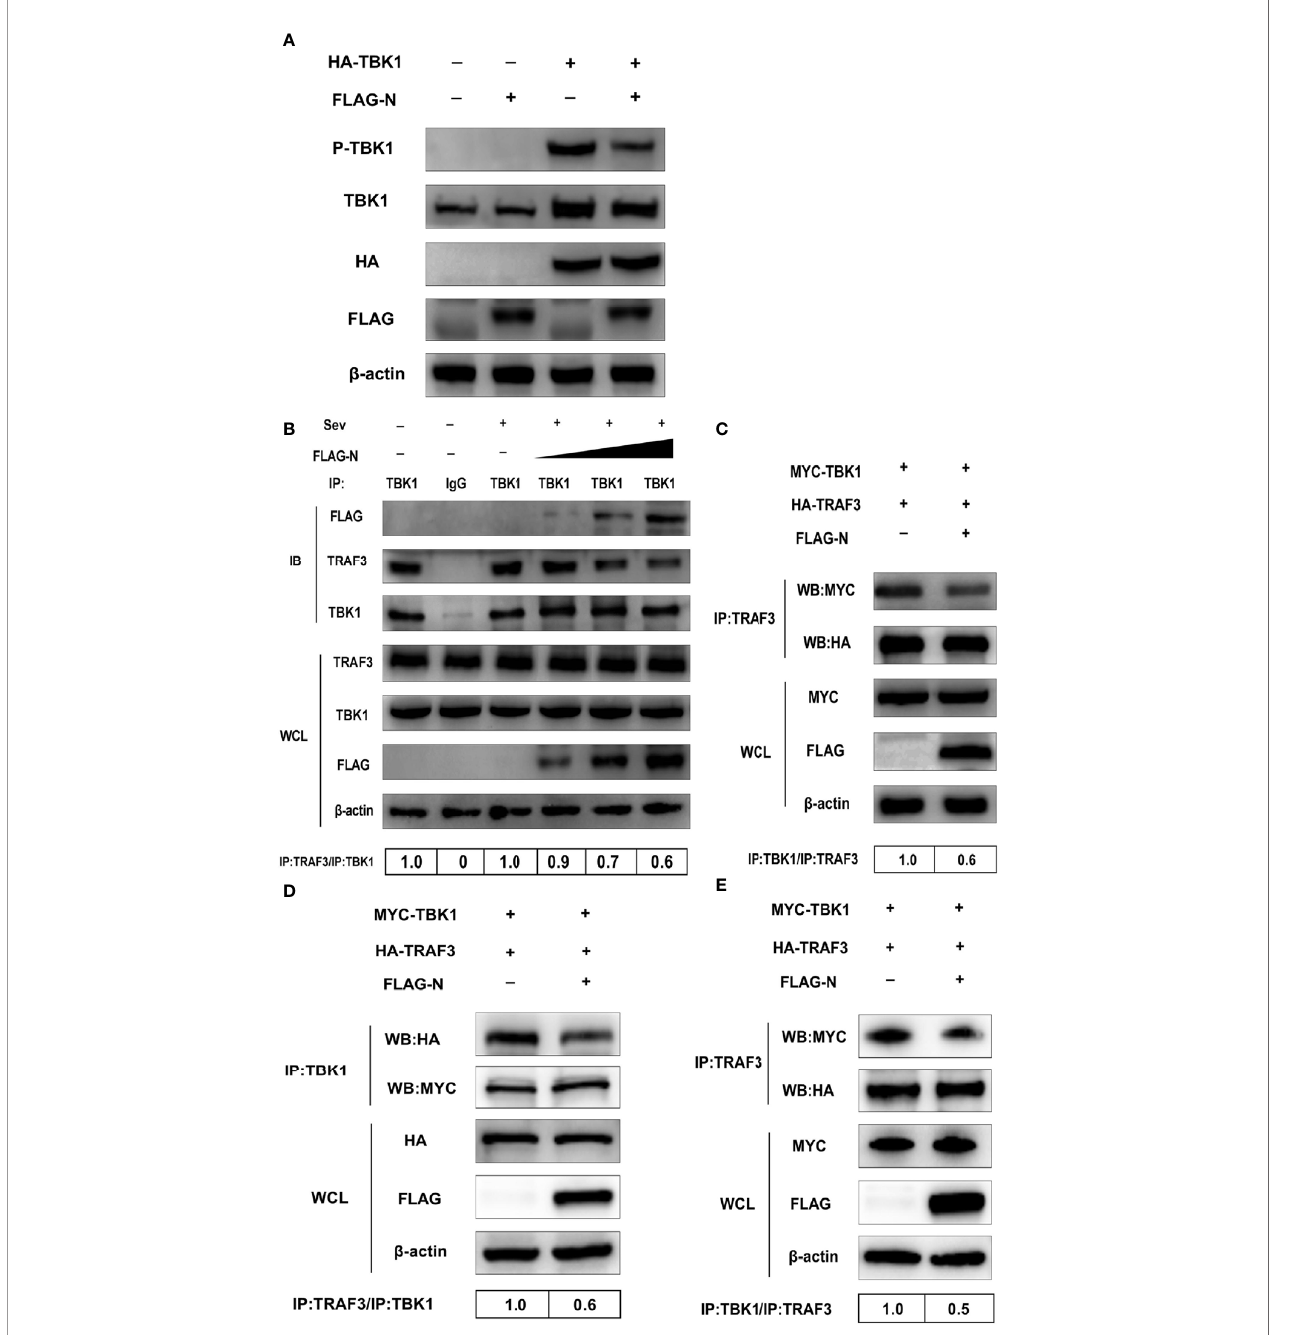
FIGURE 6 | SADS-CoV N protein disrupts the interaction between TBK1 and TRAF3. (A) HEK-293T cells were co-transfected with expression plasmids pCMV- FLAG-N and HA-TBK1 or mock-transfected for 24 h. The whole-cell lysates were collected and analyzed by Western blot with anti-FLAG, anti-HA, anti-TBK1, and anti-phosphorylated TBK1 monoclonal antibodies (MAbs), respectively. (B) HEK-293T cells were transfected with plasmids pCMV-FLAG-N with increasing quantities or mock-transfected for 24 h, and cells were treated or untreated with Sev for an additional 12 h. The whole-cell lysates were collected and immunoprecipitated with the protein A/G magnetic beads containing the anti-TBK1 antibody or normal rabbit IgG. (C) HEK-293T cells were co-transfected with expression plasmids MYC- TBK1 and HA-TRAF3 and pCMV-FLAG-N or empty vector for 28 h. The lysates were collected and immunoprecipitated with the protein A/G magnetic beads containing anti-TRAF3 antibody. ST cells were co-transfected with expression plasmids of porcine MYC-TBK1 and porcine HA-TRAF3 and pCMV-FLAG-N or empty vector for 28 h. The whole-cell lysates were collected and immunoprecipitated with the protein A/G magnetic beads containing anti-TBK1 antibody (D) or anti-TRAF3 (E) . The protein expression levels were analyzed by Western blot with anti-FLAG, anti-TRAF3, anti-TBK1, anti-MYC, anti-HA, and anti- b -actin monoclonal antibodies (MAbs), respectively. Levels of TRAF3 or TBK1 after immunoprecipitation were quantitated densitometrically and corrected with TBK1 or TRAF3 in immunoprecipitation, and the ratio between the immunoprecipitated and co-immunoprecipitated proteins in untreated cells was set as